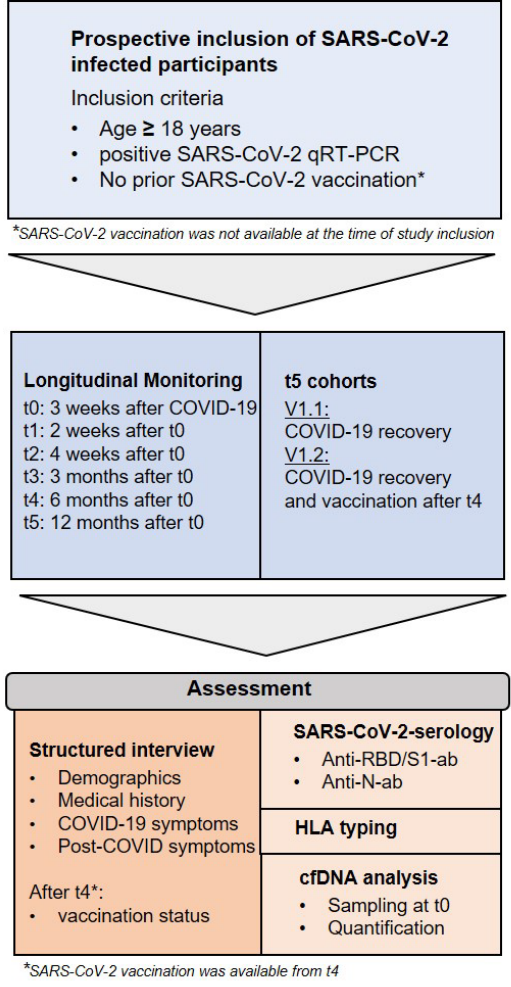
Figure 2. Inclusion criteria and study design. Table 1. cohorts and trends.